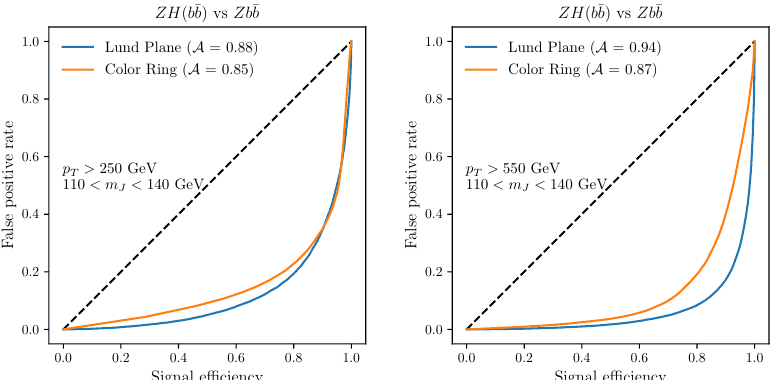
Figure 2: CNN (used for the Lund jet plane images) and color ring ROC curves for H → b ¯ b analysis [ 3 ] .